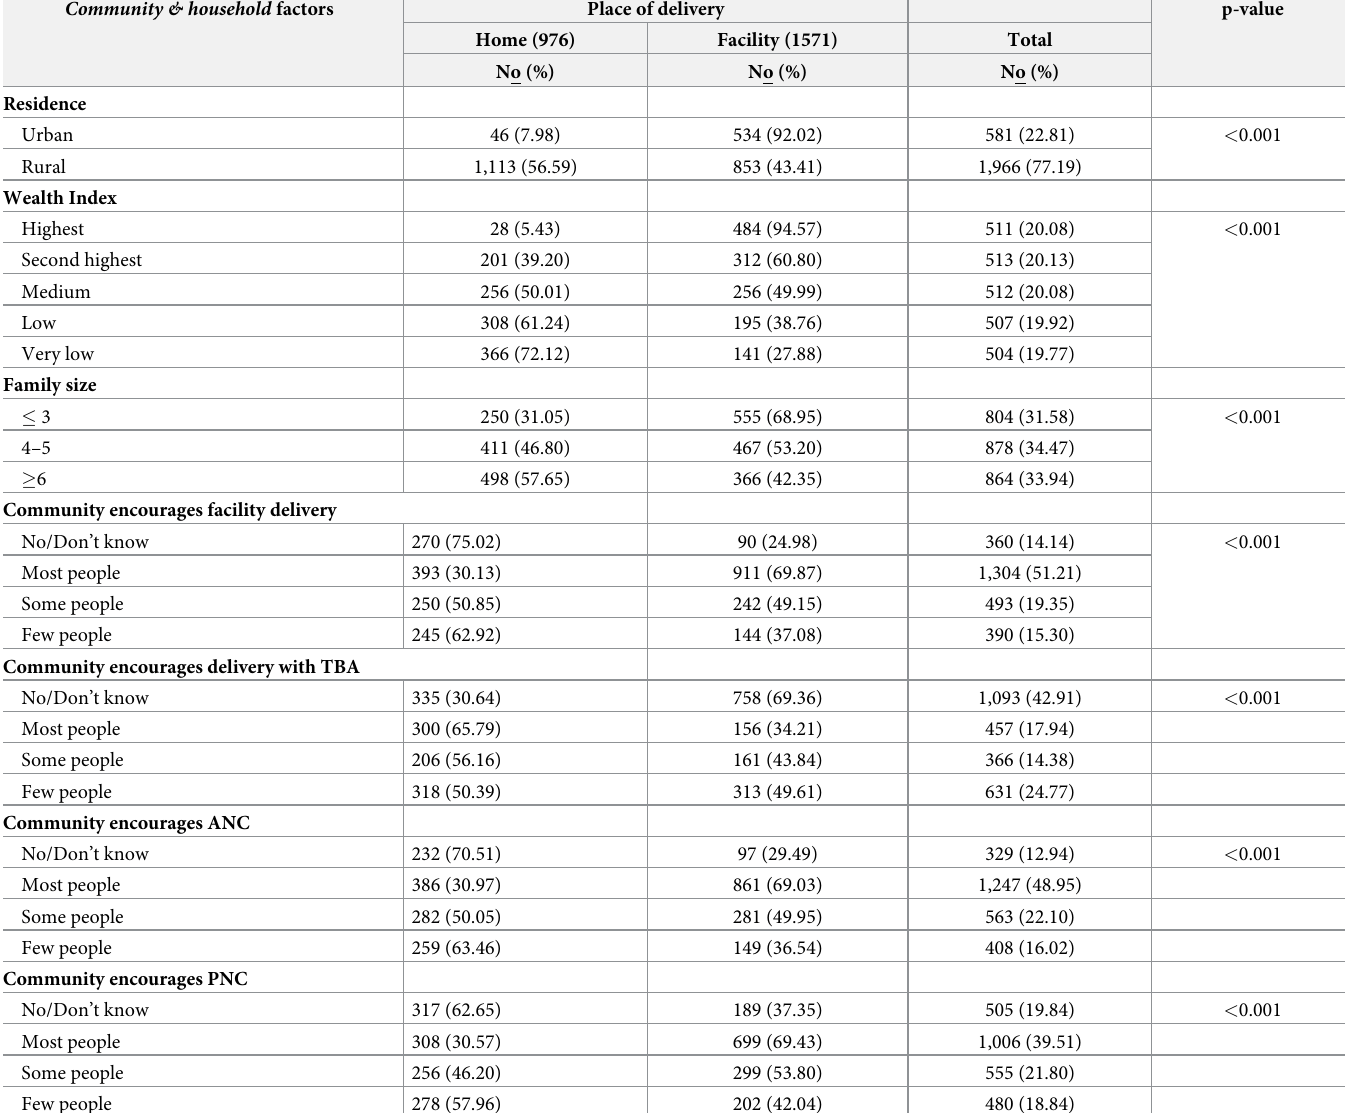
Table 2. Community & household factors by place of delivery, PMA-Ethiopia